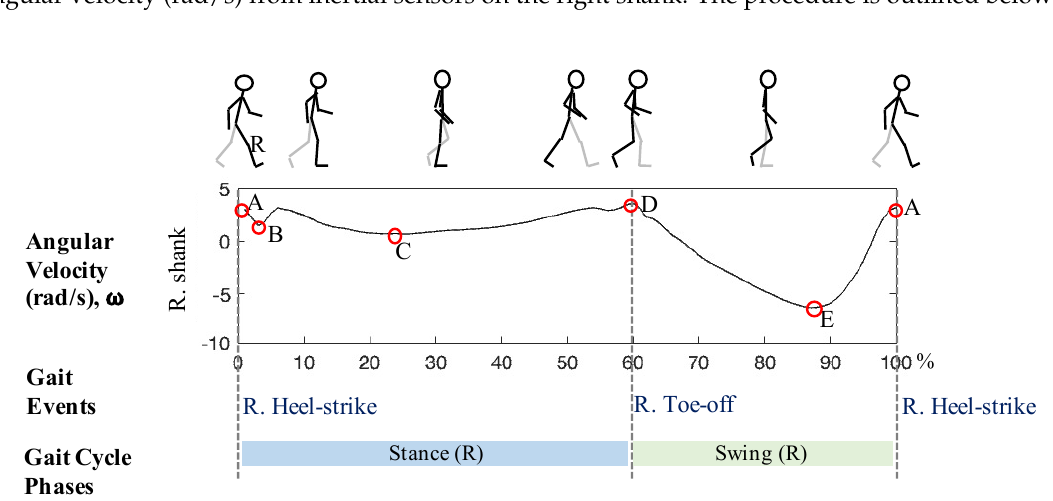
Figure A1. Graphical overview of the algorithm for detecting temporal gait events. Sample profile of the sagittal angular velocity (rad/s) from the right shank sensor is depicted for one complete gait cycle (100%) recorded during empty-handed condition. A = Right heel-strikes, B and C = minimum peaks within the right leg stance, D = Right toe-off, E =